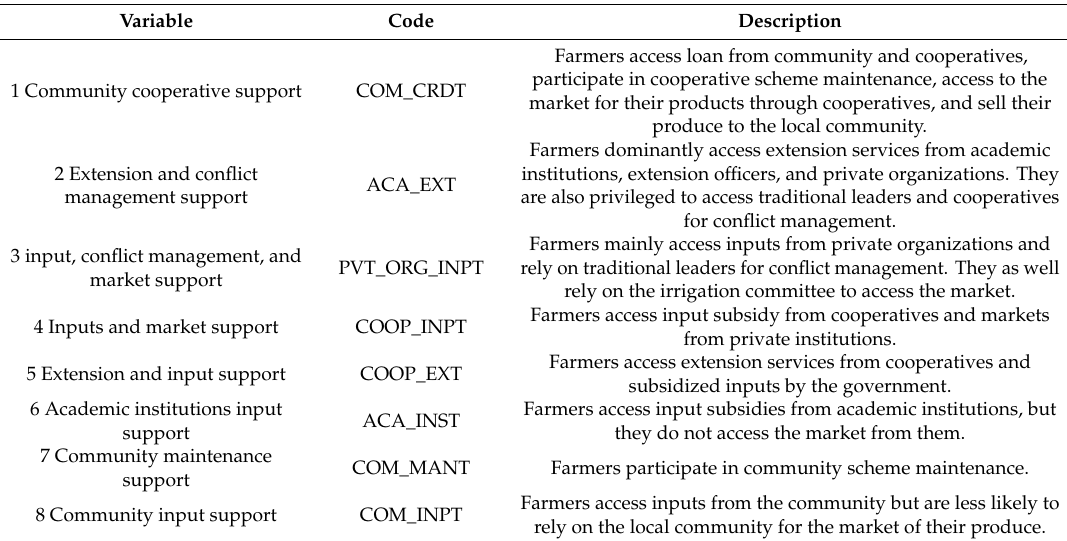
Table 7. Variable definition of institutional factors.